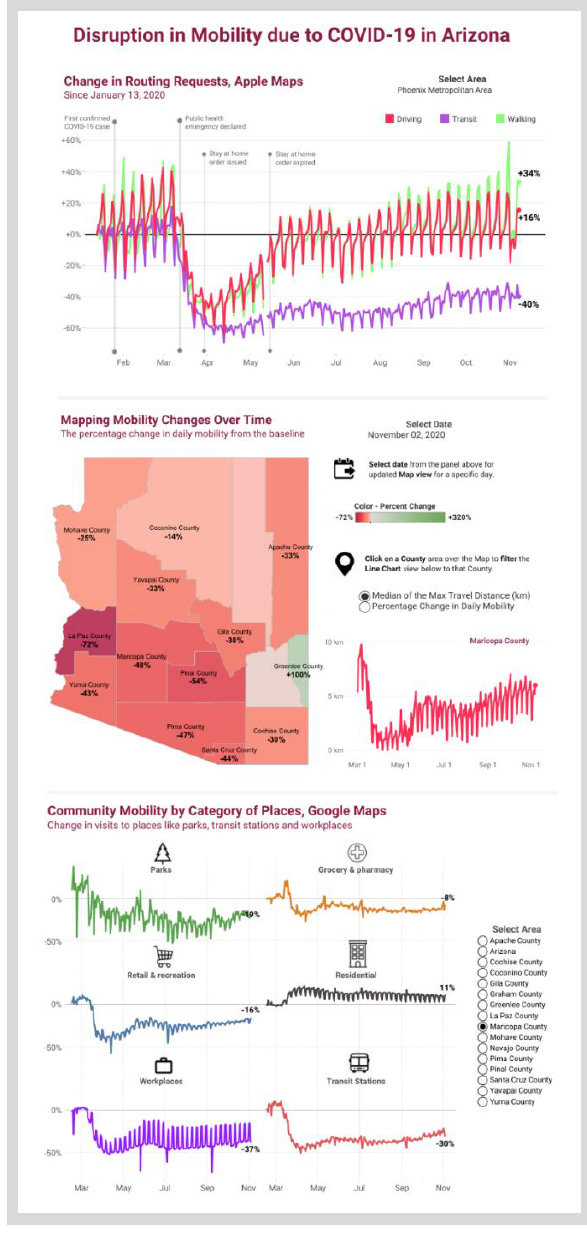
Figure 2. A screenshot of the Mobility Tracking Dashboard. Figure 2 provides a snapshot of the “Mobility Tracking Dashboard” (Praharaj et al. 2020b), which aims to measure how travel behavior was impacted in the wake of the COPVID-19 pandemic, due to stay-at-home policies, work stoppages, and social distancing observances designed to slow the spread of COVID-19. This dashboard brings together aggregated and anonymized mobility data from discrete sources and visualized those through charts and maps for exploration at different geographies and spatial scales. Following our template, we aligned the dashboard in three